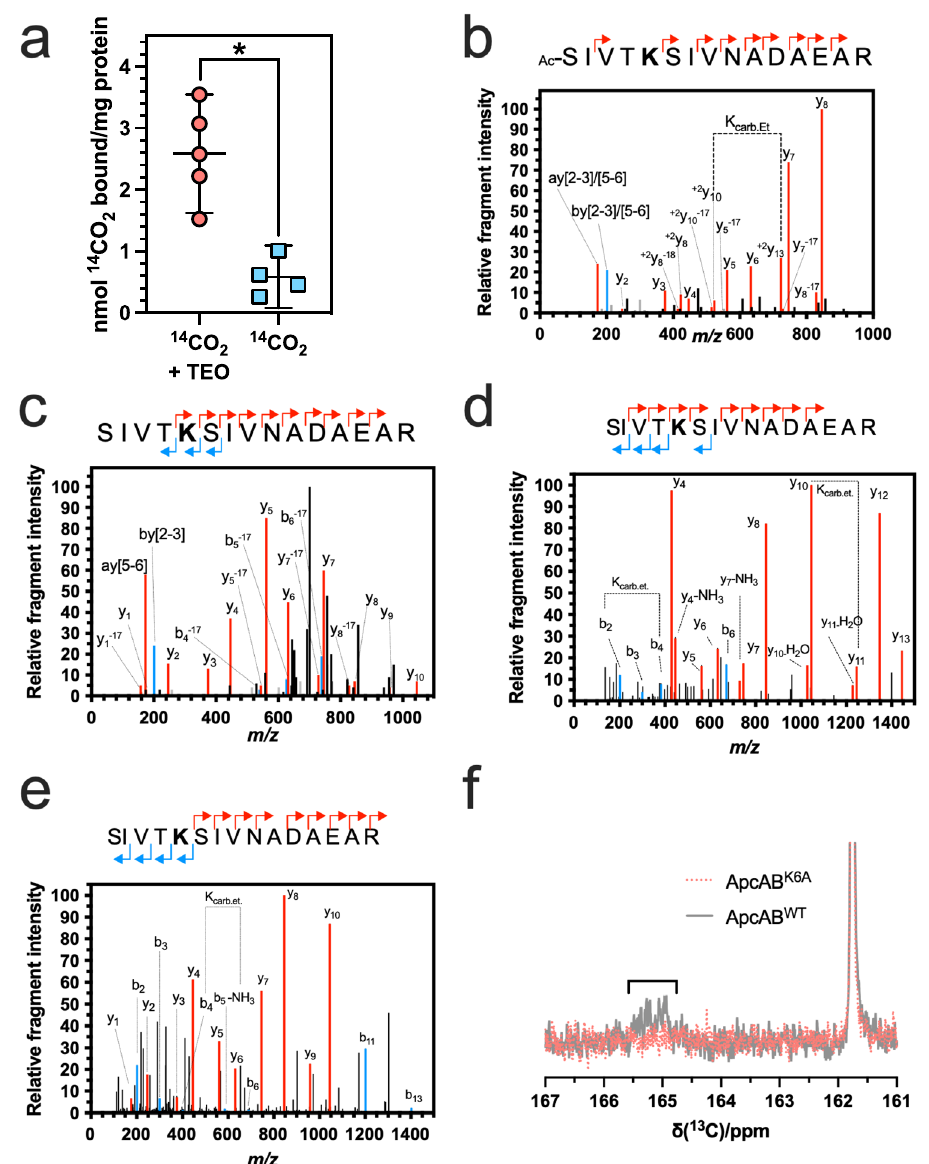
Fig. 1 | CO 2 binds ApcA. a Demonstration of exchangeable CO 2 -binding sites on Synechocystis proteinextract.CO 2 trappedontoproteinextractof Synechocystis sp. PCC 6803 (* p =0.002, two-tailed t -test, n =5 independent replicates for 14 CO 2 + TEO and n =4 independent replicates for 14 CO 2 only, t =4.794, df =7, mean±95% CI). b – e Demonstration of exchangeable CO 2 -binding sites on ApcA by MS/MS. Plots of relative fragment intensity versus mass/charge ratio (m/z) for fragmenta- tion data from MS/MSidentifying ethyl-trappedcarbamate on whole Synechocystis sp. PCC 6803 ( b ), isolated phycobilisomes from Synechocystis sp. PCC 6803 ( c ) or recombinant Synechococcus sp. PCC 7002 ApcAB WT ( αβ ) 3 trimers ( d , e ) in the presence of 12 CO 2 ( b – d ) or 13 CO 2 ( e ). Peptide sequences indicate predominant +1y